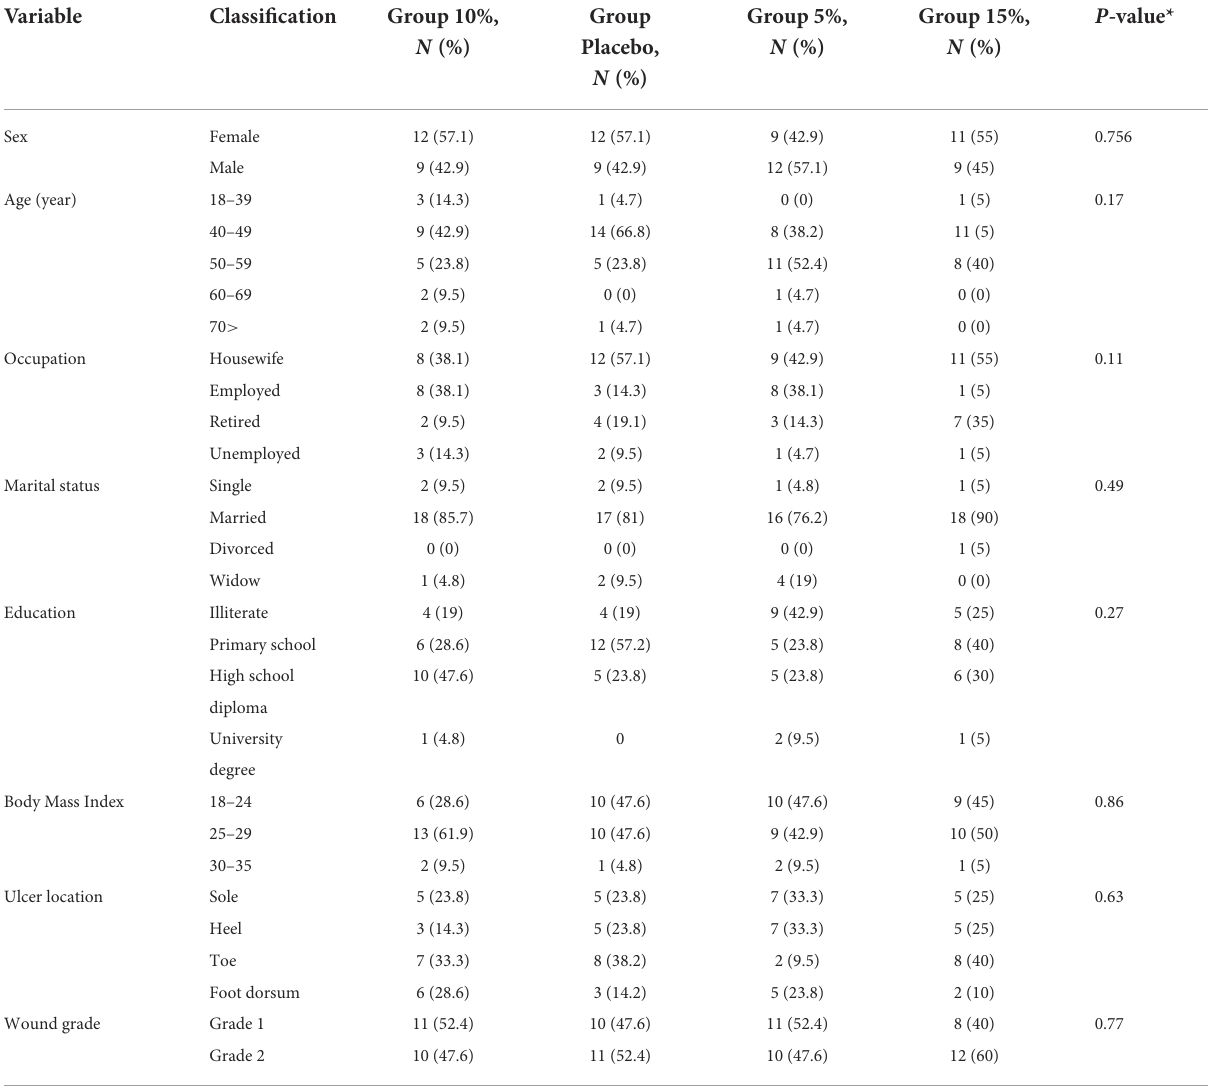
TABLE 2 Frequency distribution and percentage of demographic information of the four groups of patients participating in the study.